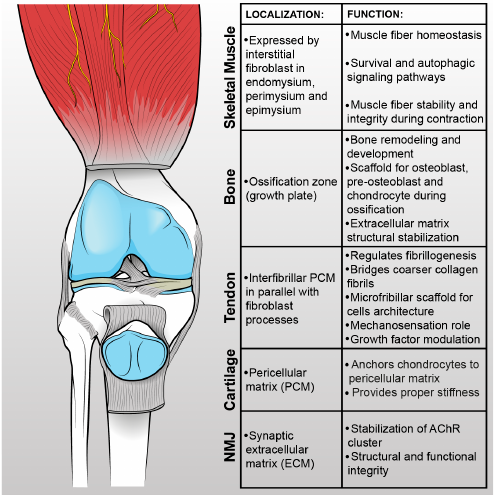
Figure 1. The role of collagen VI in different tissues: Skeletal Muscle, Bone, Tendon, Cartilage and Neuromuscular Junction (NMJ) .